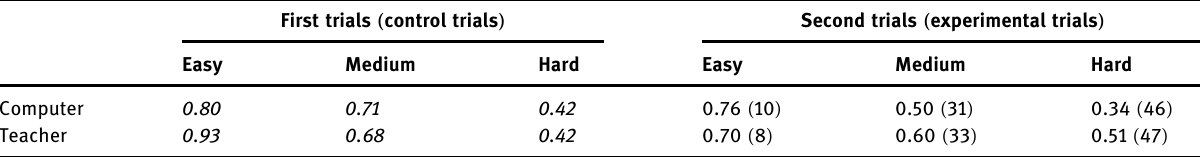
Table 1: Experiment 1: Participants ’ test performance measured via accuracy score as a function of di ffi culty and trial session First trials ( control trials